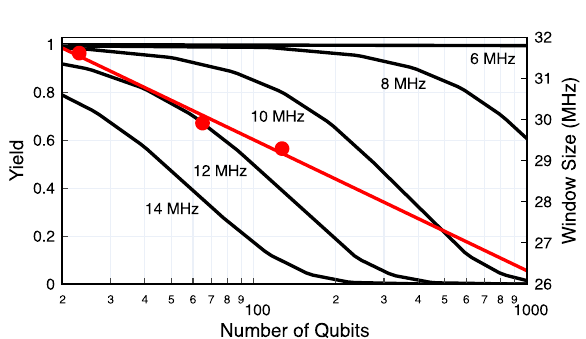
Fig. 5 Yield scaling for heavy-hexagon lattice. Fixed window size model. (Back curves, left axis) Model yields for σ f ranging from the 14 MHz demonstrated in this work to 6 MHz that would optimize future scaling yield beyond the 1000Q level. (Red points and curve, right axis) Fixed window size fi ts to the d = 3, d = 5, and d = 7 heavy- hexagon lattice, as well as a fi t of these values to expression A þ B (cid:3) log ð N Þ , extrapolated from 20 to 1000 qubits. This trend illustrates varying frequency-crowding constraints as a function of lattice size.